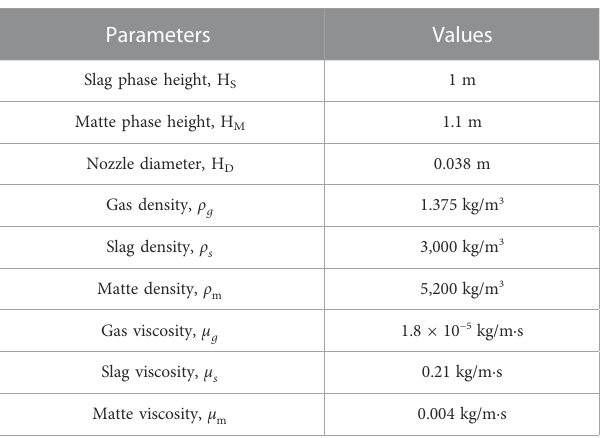
TABLE 1 Main physical parameters.